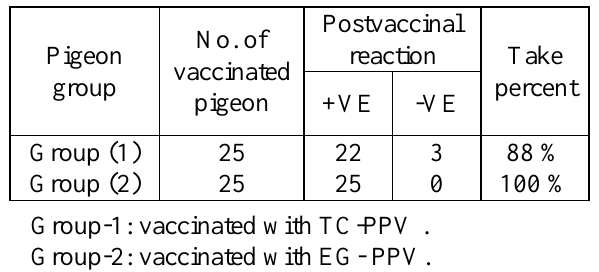
Table 2: Postvaccinal reaction in pigeon groups vaccinated by TC-PPV and EG- PPV: Postvaccinal No. of reaction Take Pigeon vaccinated group percent pigeon +VE -VE Group (1) 25 22 3 88 % Group (2) 25 25 0 100 % Group-1: vaccinated with TC-PPV . Fig. 1: Virus Neutralization Index in vaccinated pigeons with TC-PPV and EG-PPV. 3.Assessment of maternal immunity in squabs from vaccinated layer pigeon with PP vaccines: